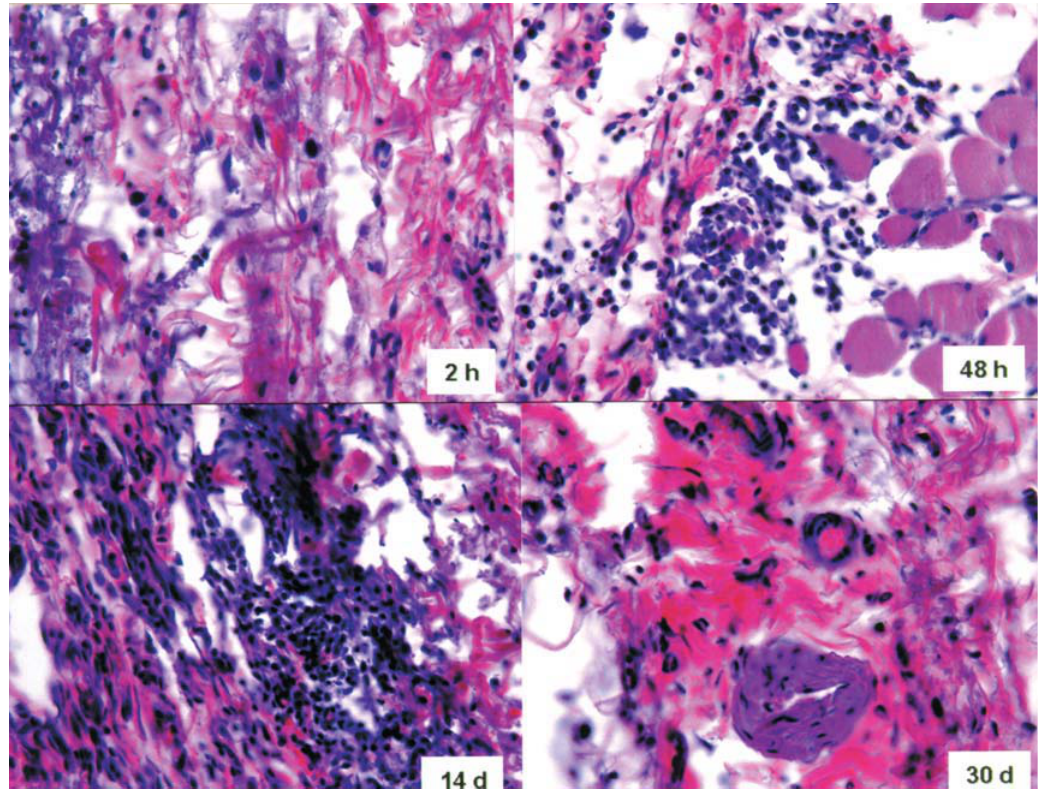
FIGURE 6 - Reaction of rat subcutaneous connective tissue to 2.0% Chlorhexidine gel (H.E.;